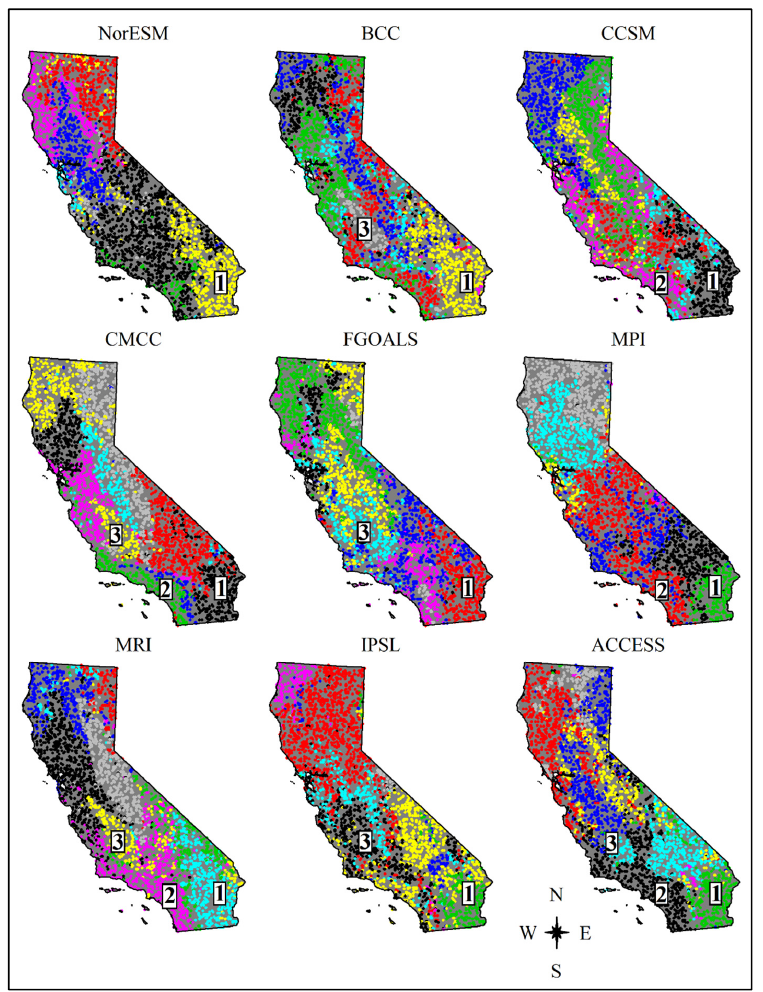
Figure 6. Network-based clusters illustrating spatial temporal heterogeneity of drought in California, USA as measured using time series PDSI for the period 2012–2018. The colors are only used here to show the presence of clusters. The colors do not indicate similar clusters across models. Number labels are used to show clusters with similar spatial extents among models.